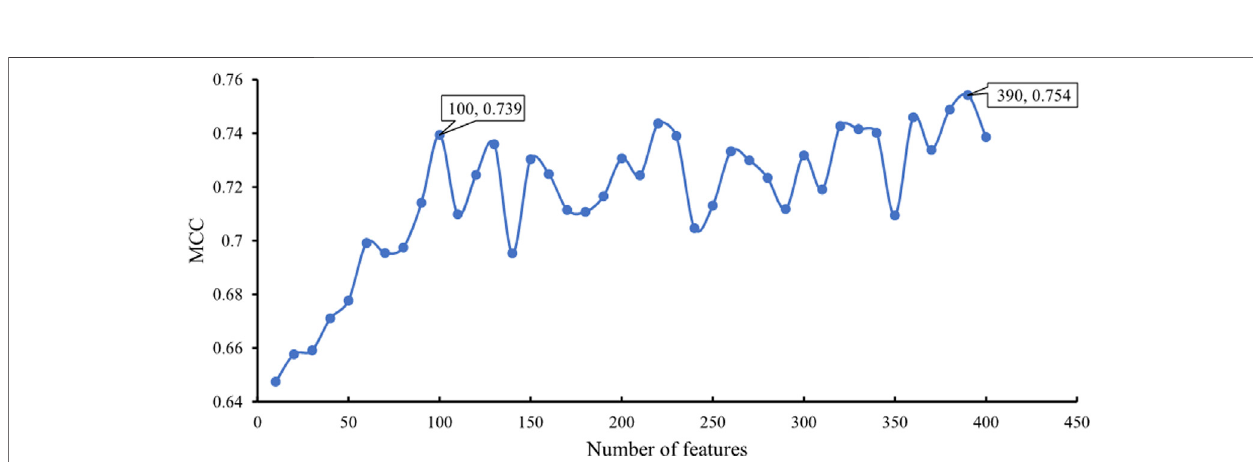
FIGURE4| IFScurvewithDTclassi fi cationalgorithmonthedifferentnumberoffeatures.TheDTprovidesthehighestMCCof0.754whenthetop390featuresare adopted. DT yields high performance with MCC of 0.739 when only 100 features are used.